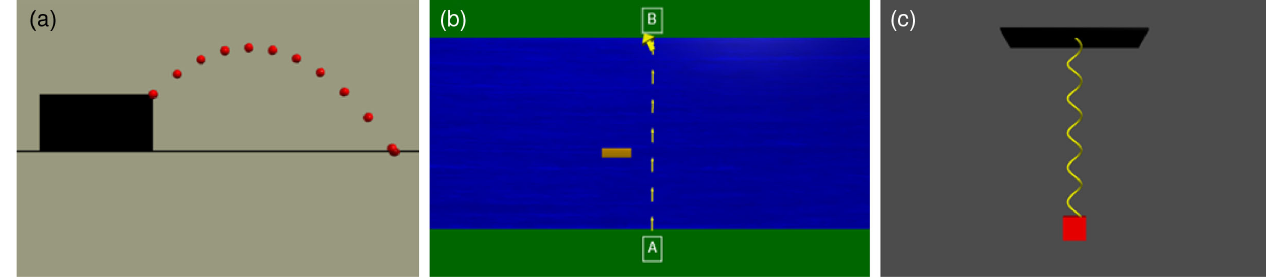
FIG. 9. Outputs displayed in Michael ’ s solutions for computational models of (a) projectile, (b) river crossing, and (c) spring energy